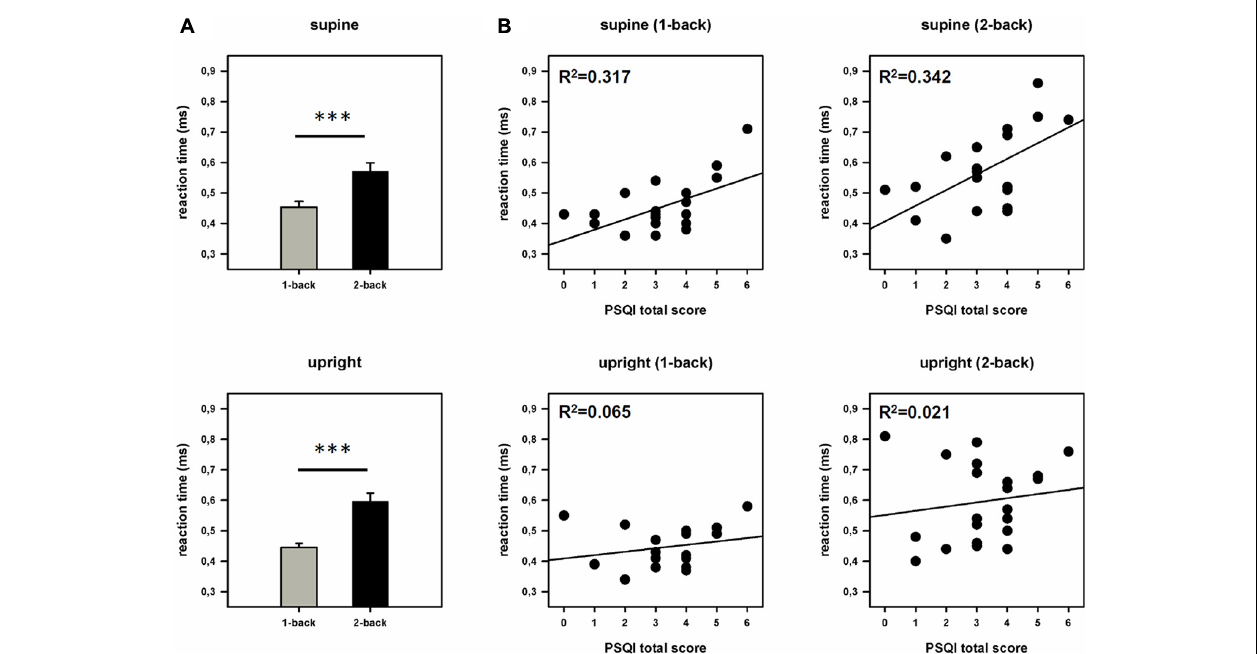
FIGURE 3 | Behavioral data. (A) Reaction times (RTs) during both work load conditions and postures. Error bars indicate SEM. (B) Scatter plots and coefficients of determination ( R 2 ). Displayed is the relationship between sleep quality (PSQI total score) and reaction times (RTs) in the supine and the upright posture. *** p <